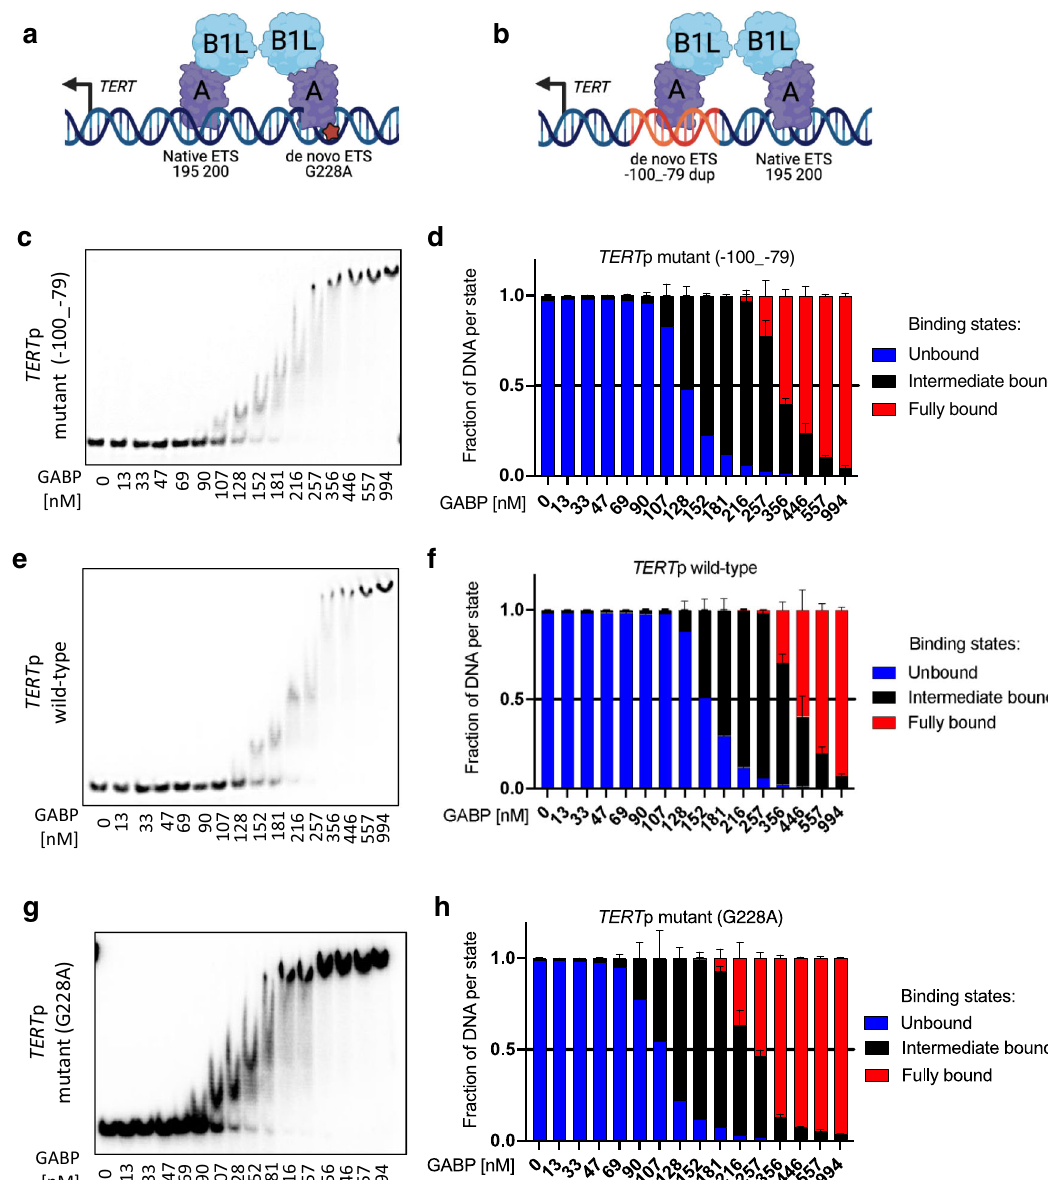
Fig. 3 | GABPB1L containing GABP complexes bind the TERT promoter dupli- cation. a , b Schematic of the GABP heterotetramer TF complex binding to the de novo and native ETS motifs of the TERT p with the G228A mutation or c. − 100_ − 79 duplication,respectively. The fi gureswerecreatedwith BioRender.Representative gels ( c, e , g ) and quanti fi cation ( d , f , h ) of EMSAs comparing binding af fi nity of